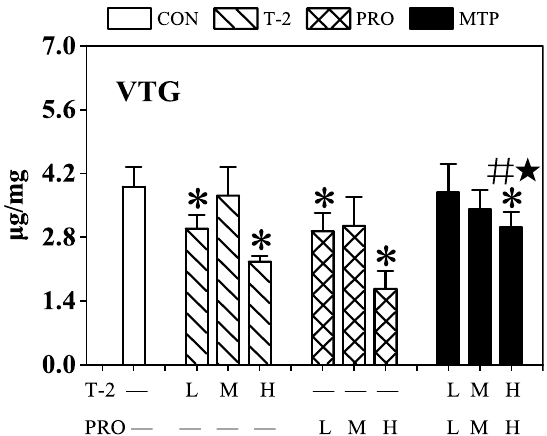
Fig. 3 The VTG level of zebrafish treated with T-2 PRO and their combinations. Each bar represents the mean standard deviation ± ( n three replicates consisting of a group of 250 fish). * p < 0.05 = substantial alteration by comparison with the control; # p < 0.05 significant difference relative to the corresponding T-2 exposure; ★ p < 0.05 significant difference relative to the corresponding PRO exposure. CON control, T-2 T-2 toxin, PRO propiconazole, MTP the mixture of T-2 and PRO. L low concentration, M middle